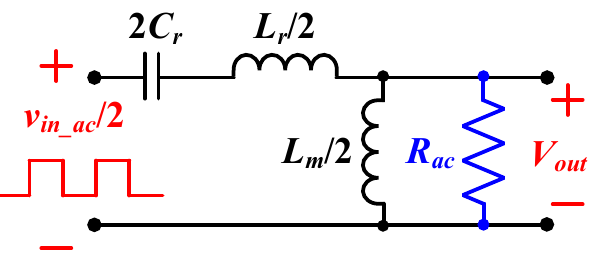
Figure 6. Equivalent circuit of Switching Pattern 3.